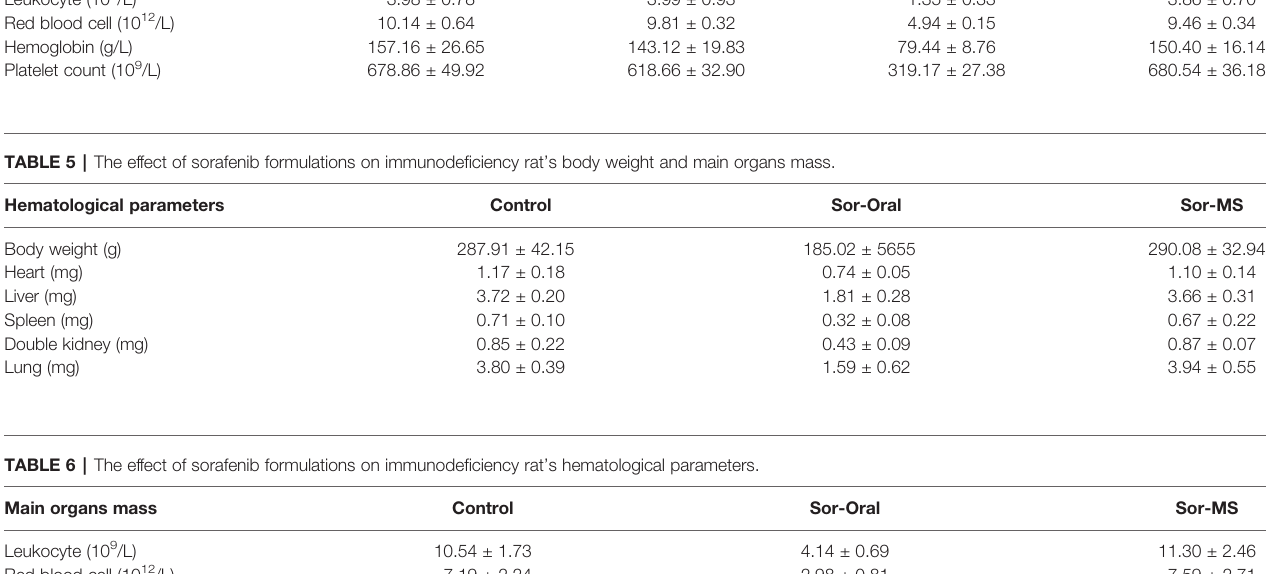
TABLE 4 | The effect of sorafenib formulations on nude mice ’ s hematological parameters. Hematological parameters